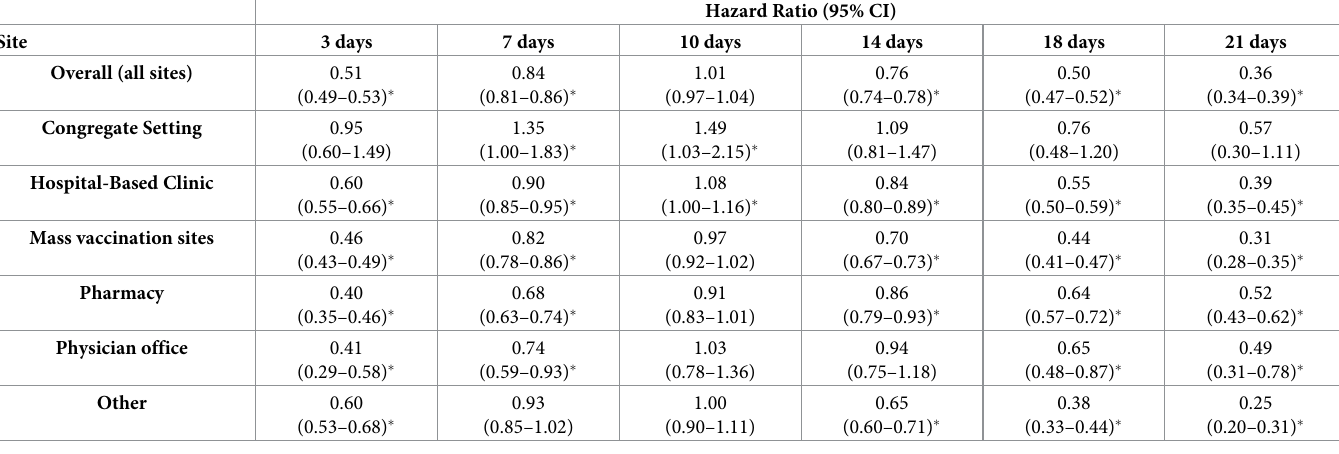
Hazard Ratio (95%